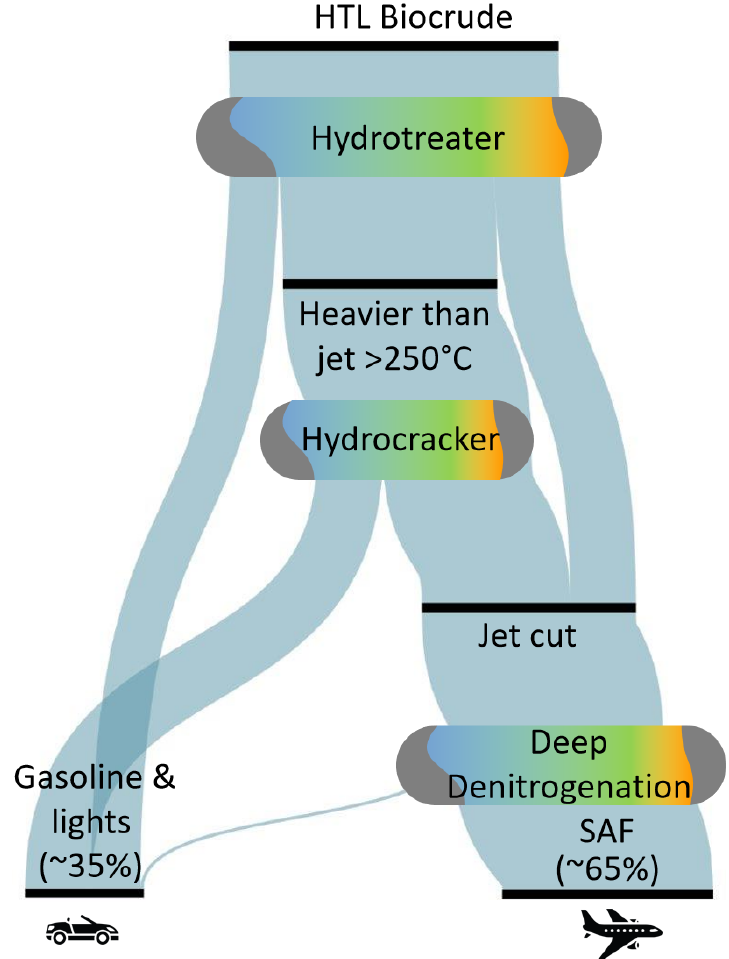
Figure 6. Flow diagram of the potential carbon yield of the jet fraction product from WWHTLB, if the HTJC undergoes hydrocracking/isomerization and this product is combined with the JFC prior to HDN upgrading.